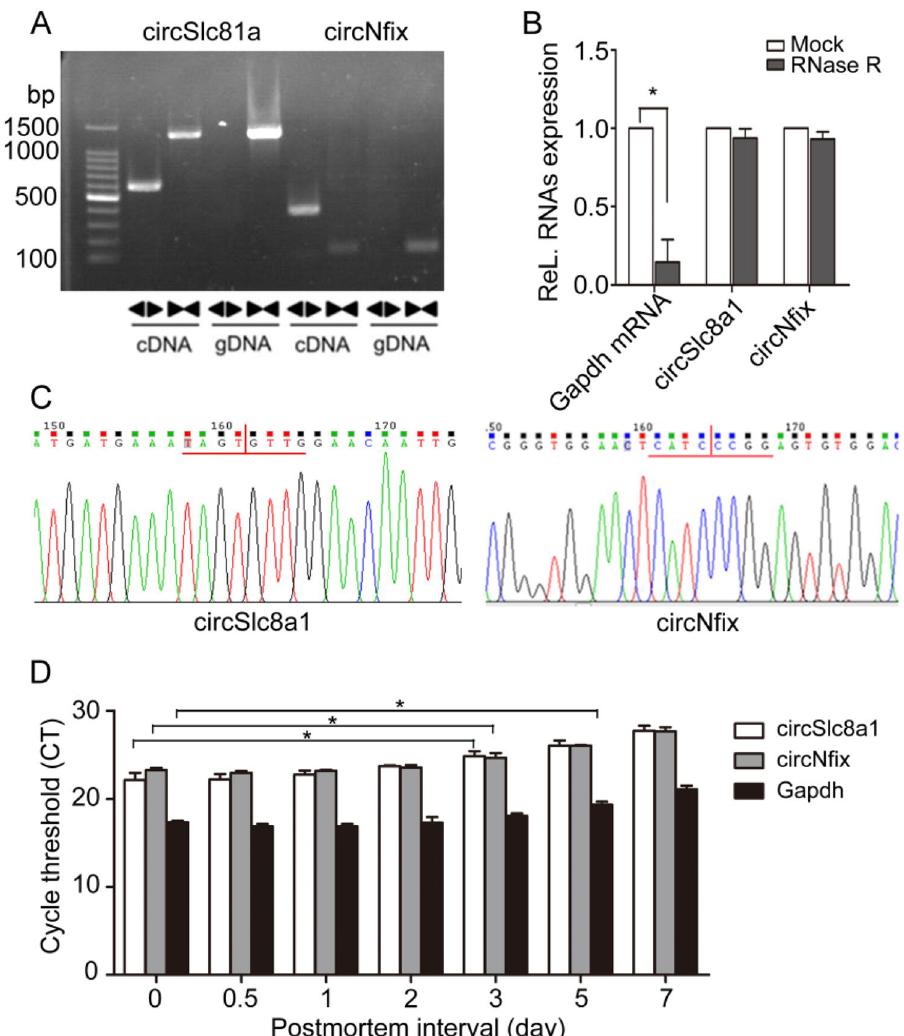
( ◄► ) and convergent primers ( ►◄ ), but could not be amplified by divergent primers from gDNA. Full-length gels are presented in Supplementary Fig. S1. online (B) Total RNA was incubated with RNase R or buffer only (Mock). After digestion, circSlc8a1, circNfix, and Gapdh mRNA was analysed by qRT-PCR. Differences between mock and RNase R were analyzed using student’s t-test, * P < 0.05, n = 3. (C) Sequence analysis validated the circular junction of the two circRNAs. (D) The CT values of circSlc8a1 and circNfix were determined by qRT- PCR at the corresponding timepoints. Differences between other timepoints group and 0-day group of each indicators were analyzed using one-way analysis of variance (ANOVA); post hoc analyses were performed using Dunnett’s multiple comparison test, * P < 0.05, n =